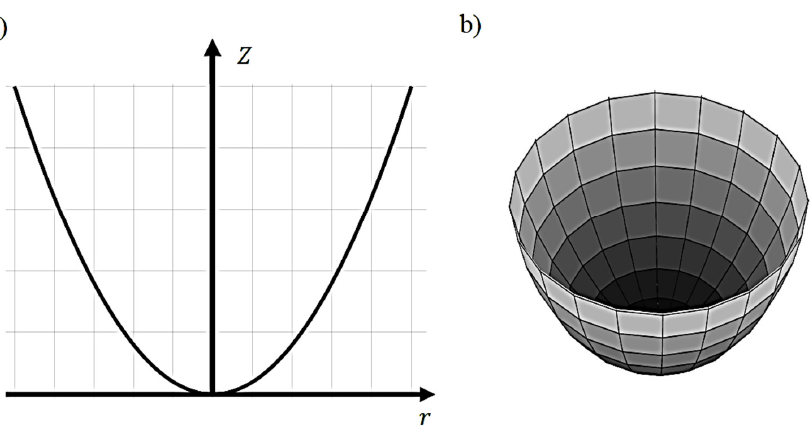
Figure 1. ( a ) A function of the form Z = Br n that is rotated about the z -axis to produce a solid of revolution. ( b ) A typical indenter shape that is described using the aforementioned function.